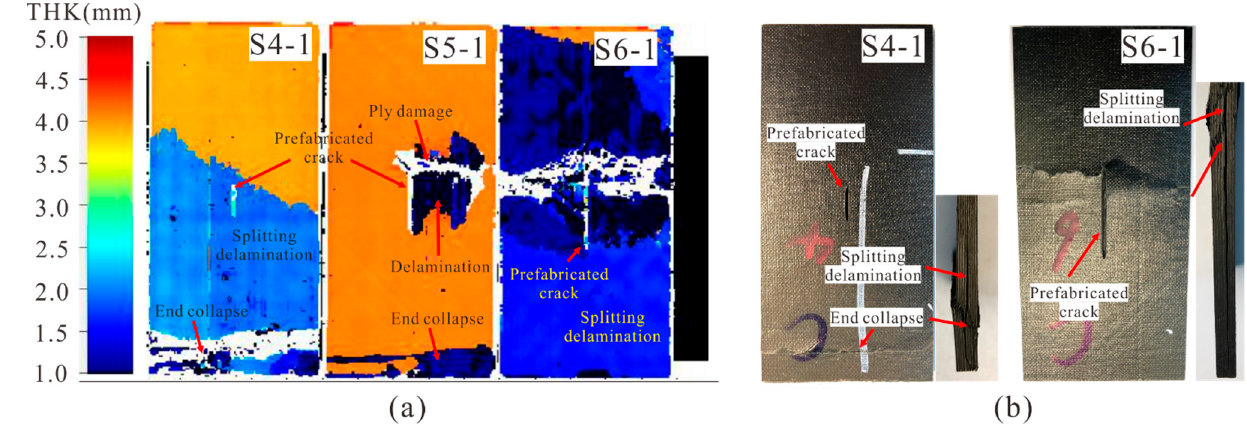
Figure 8. ( a ) C-scan results of specimens with 0° medium cracks after compression and ( b ) Failure modes comparison of S4-1 and S6-1.